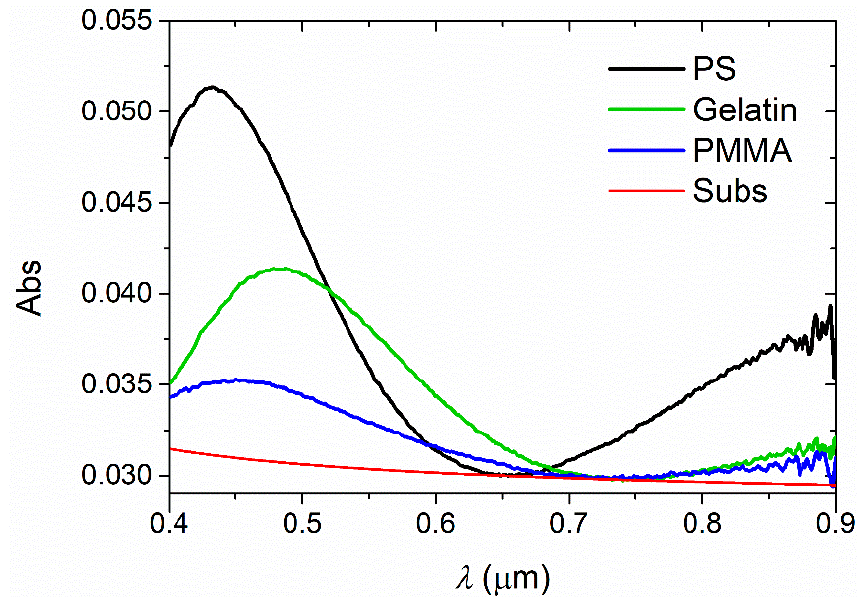
Figure 5. Experimental absorption spectra corresponding to PS ( n 833 = 1.575), gelatin ( n 833 = 1.526) and PMMA ( n 833 = 1.484) films with h in the range of 200–250 nm. The theoretical absorption spectrum calculated with Equation (6) has also been included (red solid line).